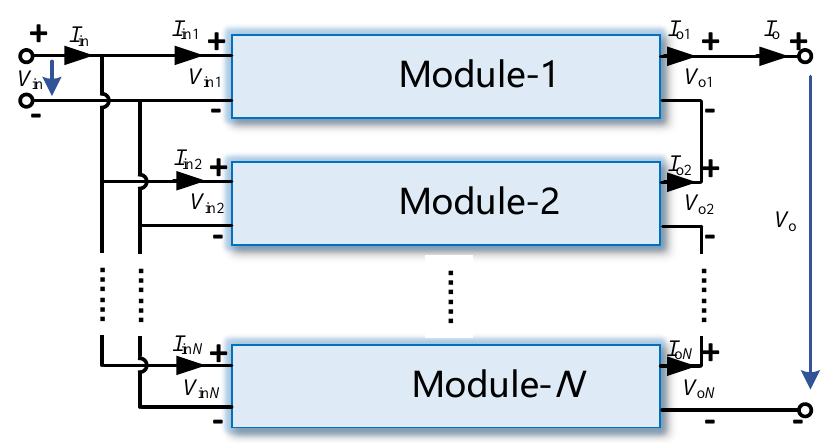
Figure 7. IPOS module cascaded PV HVDC converter.